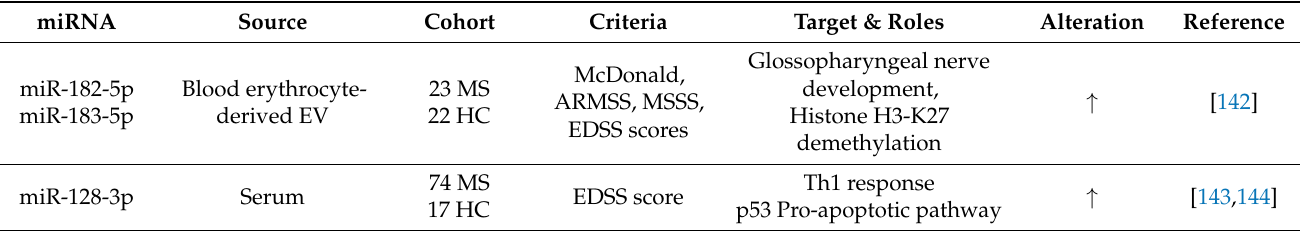
Table 3. Profile of miRNAs proposed as multiple sclerosis